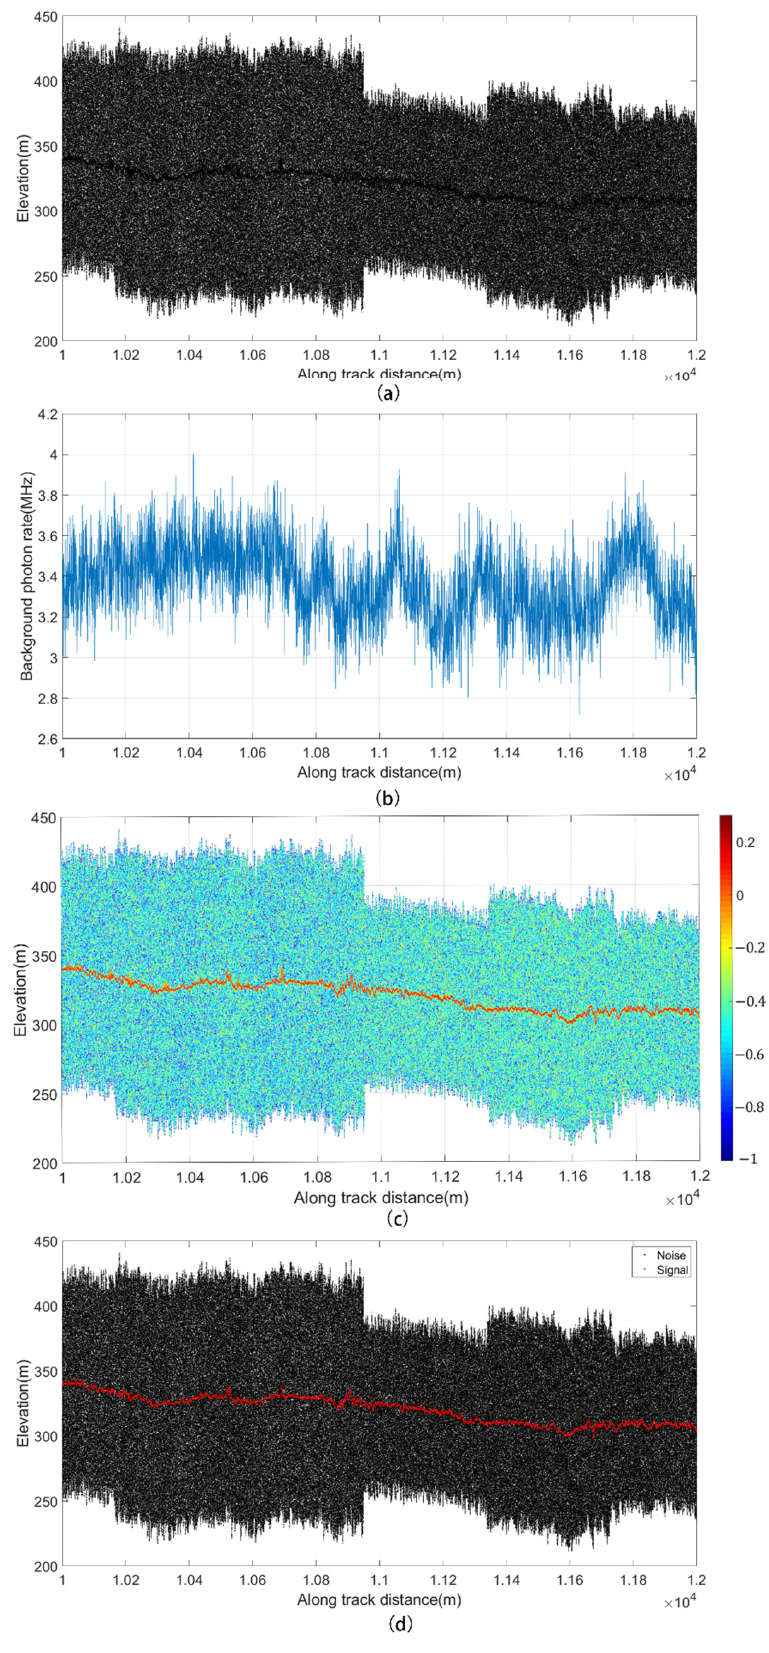
Figure 14. ( a ) Original ICESat-2 data. ( b ) Background photon counts rate. ( c ) Threshold minus the KNN distance of query points. ( d ) Denoised results.